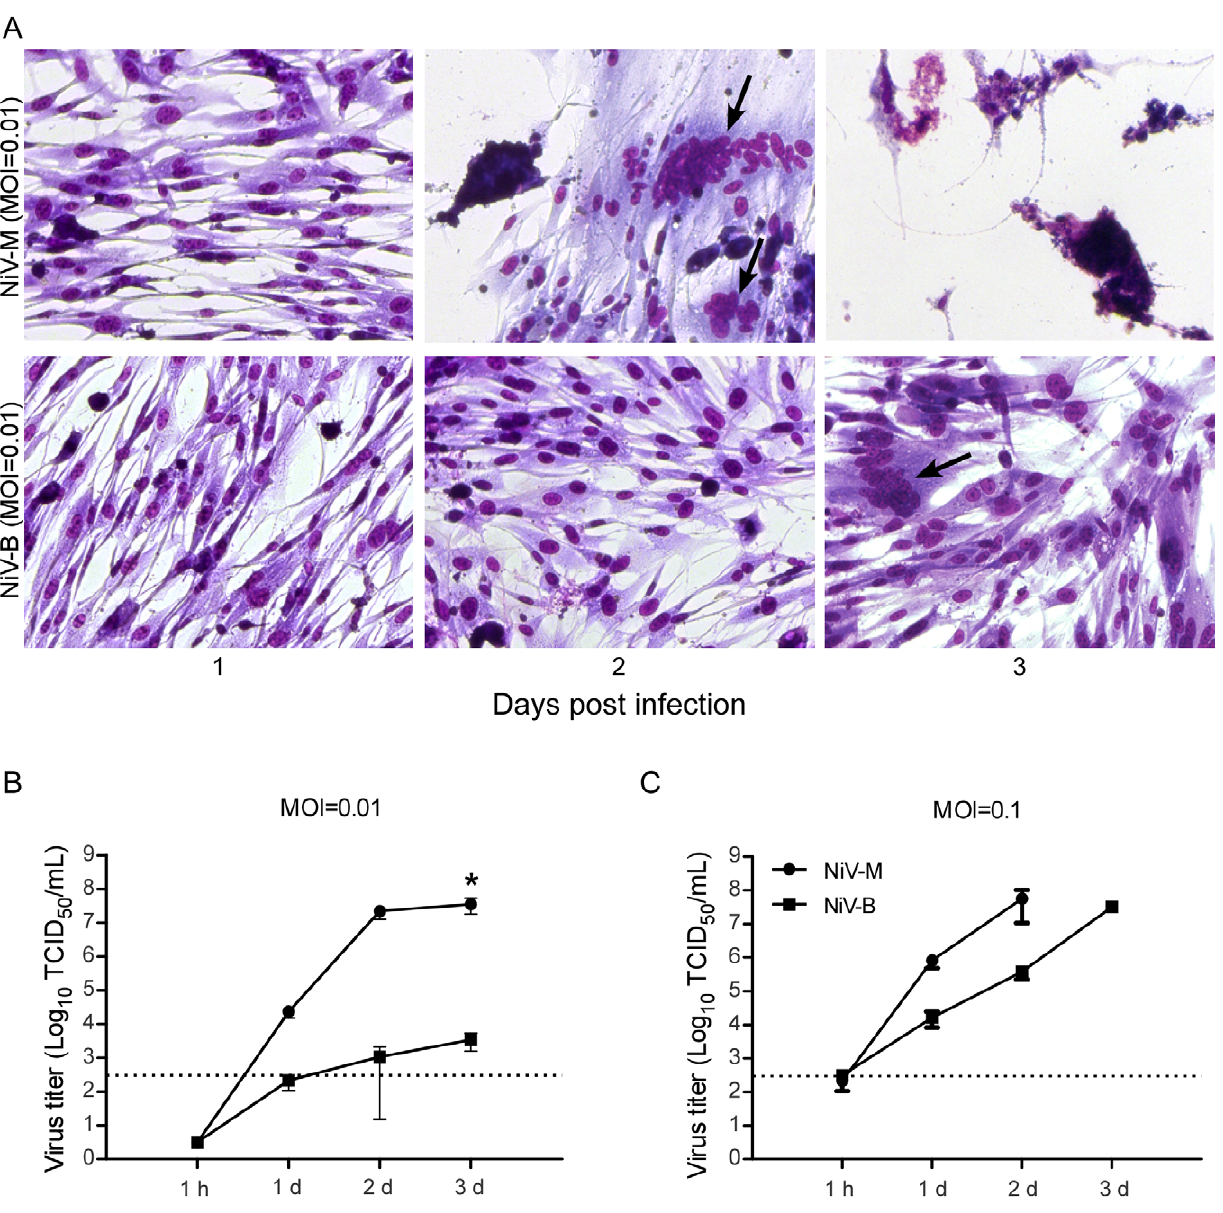
Figure 1. NiV-M replicates more efficiently and causes increased cytopathogenicity in hamster cells compared to NiV-B. To study the cytopathogenicity of these Nipah viruses, BHK-21 cells were infected with NiV-M or NiV-B at an MOI of 0.01 and stained using the Kwik Diff Kit at 1, 2, and 3 dpi (A). Arrows point to multinucleated giant cells. To examine the viral growth kinetics, BHK-21 cells were infected with Nipah virus at an MOI of 0.01 (B) or 0.1 (C). and supernatants were collected at the indicated time points. Supernatants of NiV-M at an MOI of 0.1 at 3 dpi were not collected due to extensive destruction of the cell monolayer. Virus was titrated on Vero C1008 cells and the results are expressed as the mean of three replicates and error bars indicate the SEM. The dotted line denotes limit of detection for the assay. A 2-way ANOVA with Bonferroni’s post test was used to compare the viruses (*=p , 0.05).